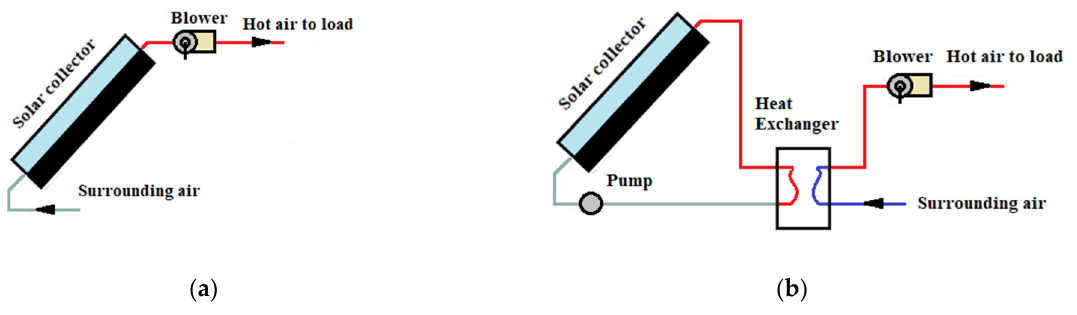
Figure 3. Solar hot air system: ( a ) Direct air system, ( b ) Indirect air system. Adapted and modified from Ref. [41], Copyright (2012), with permission from Elsevier.